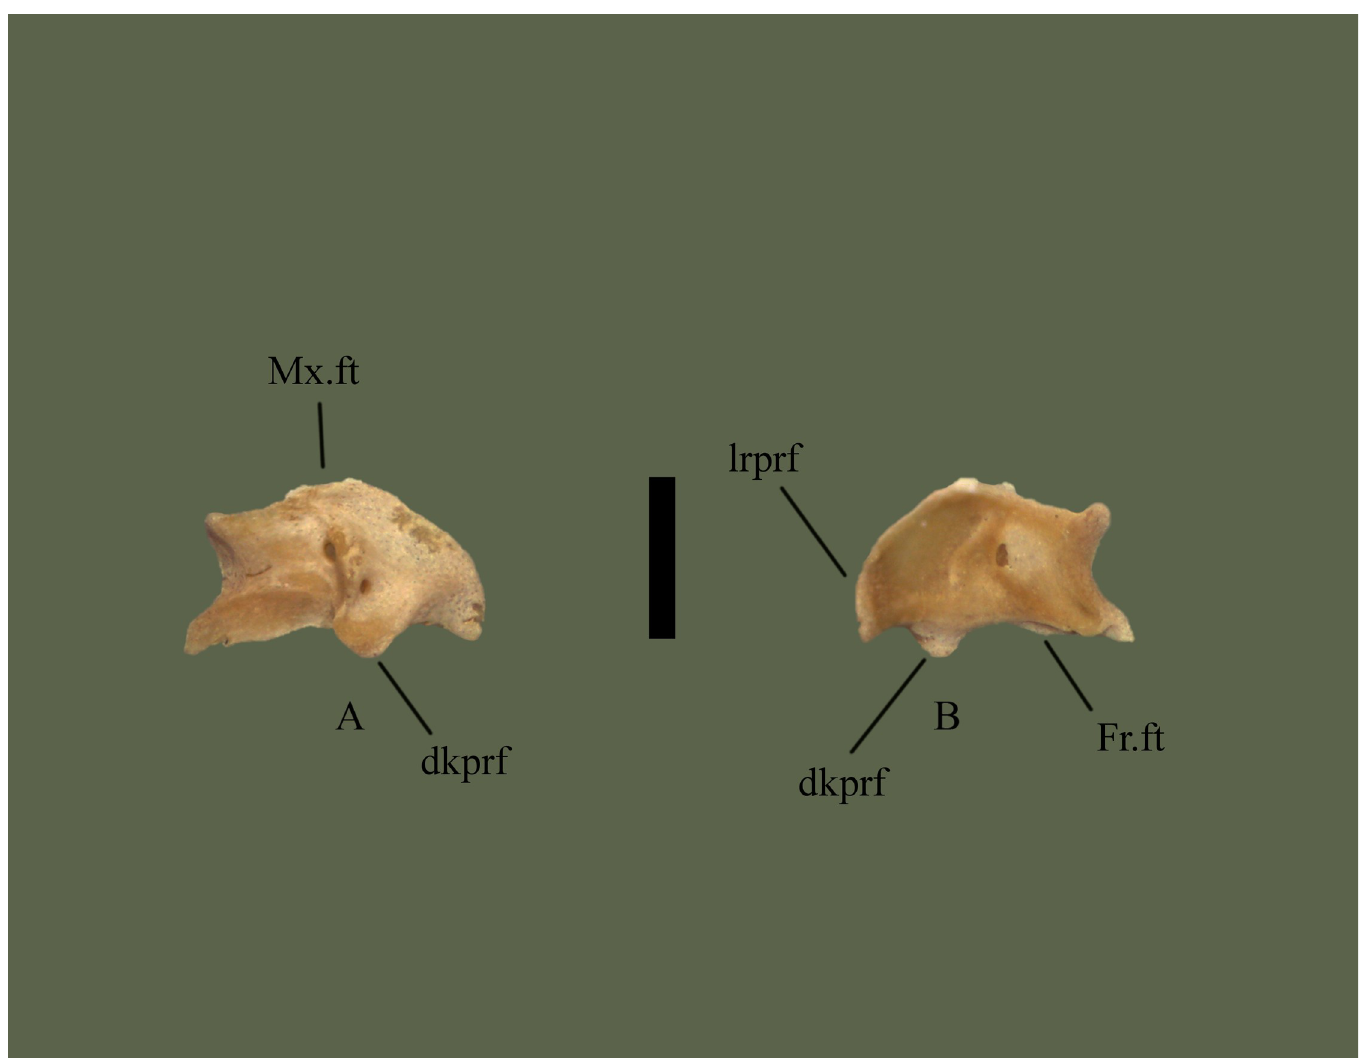
Fig 16. Right prefrontal (ETVP 3306) in dorsal (A) and ventral (B) view . Anterior is to the top. Scale bar = 1mm. Abbreviations: Mx.ft = maxillary facet; Fr.ft = frontal facet; dkprf = dorsal knob of prefrontal; lrprf = lateral ridge of